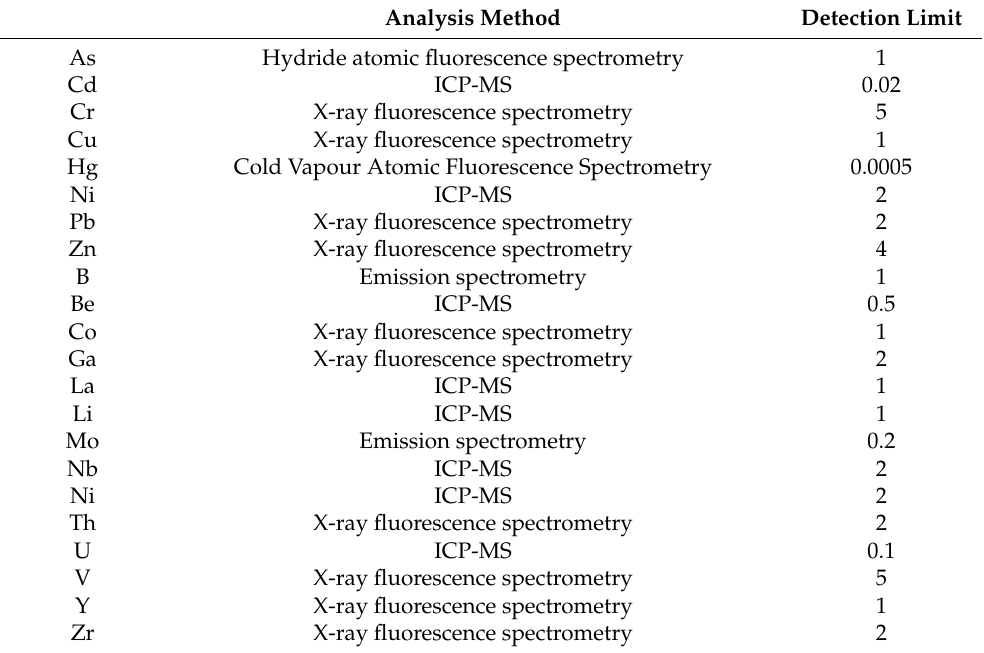
Table 1. Element analysis method and detection